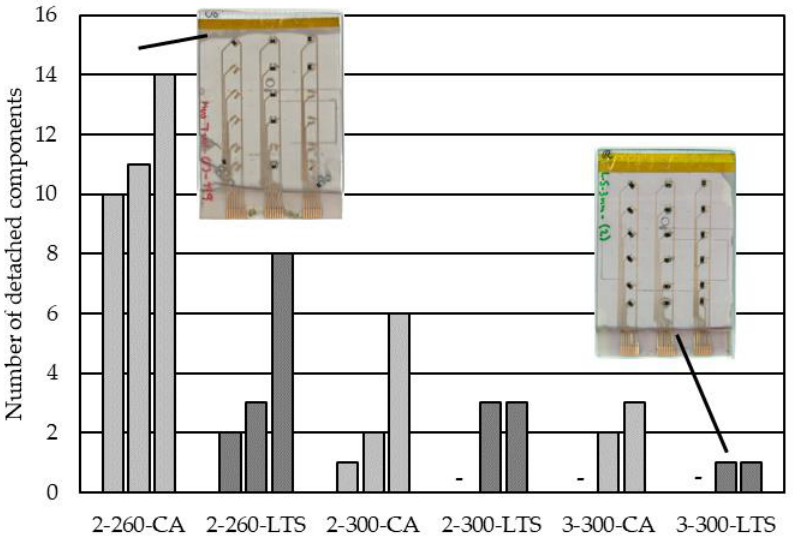
Figure 8. The number of detached components per setting (each foil comprising 18 components total). The labeling reads mold thickness (mm) – melt temperature (°C) – material for assembling (/).